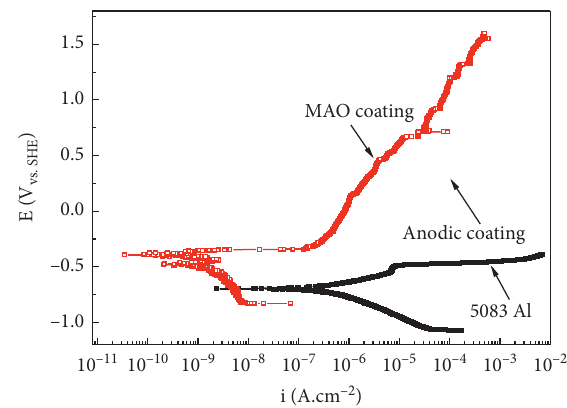
Figure 5: Potentiodynamic polarization curves for MAO coating, anodic oxidation coating, and 5083 aluminum alloy in 3.5 wt.% NaCl